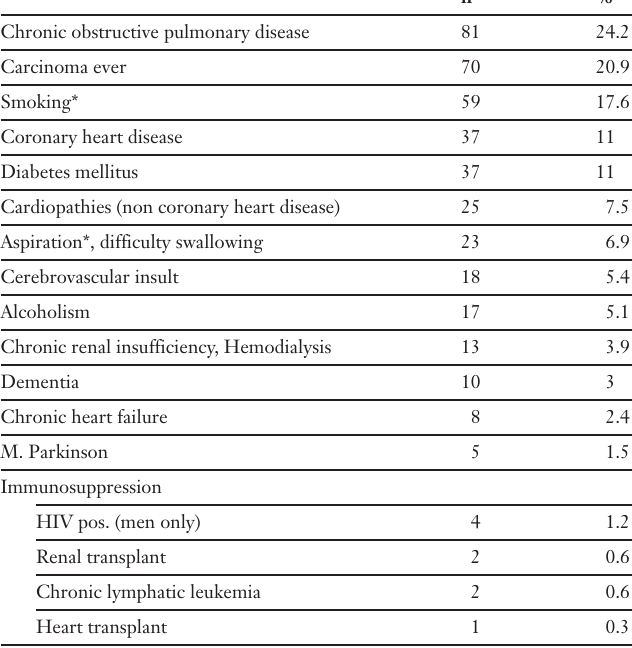
Comorbidities and predisposing factors to pneumonia (n = 335).